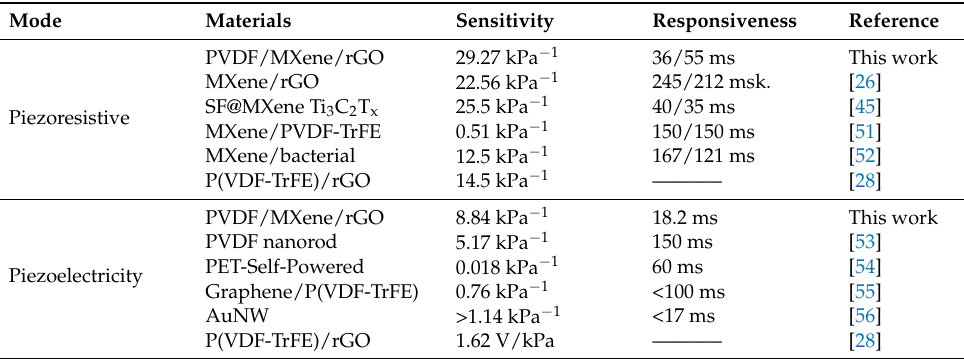
Table 1. Performance comparison of the PMR flexible sensor.